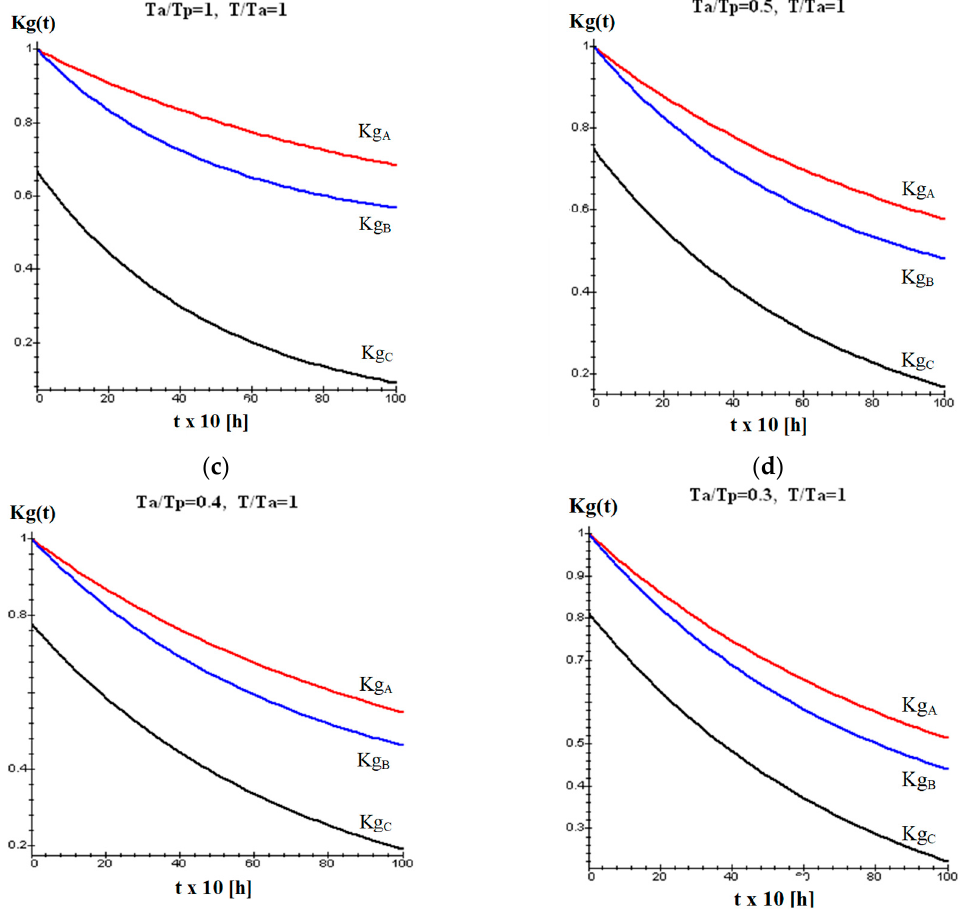
Figure 5. Courses of the readiness function K g (t) of the operation process of wind power plant which uses various models of maintenance systems for condition T/T a = 1. Symbol in the Figure 5. represent: